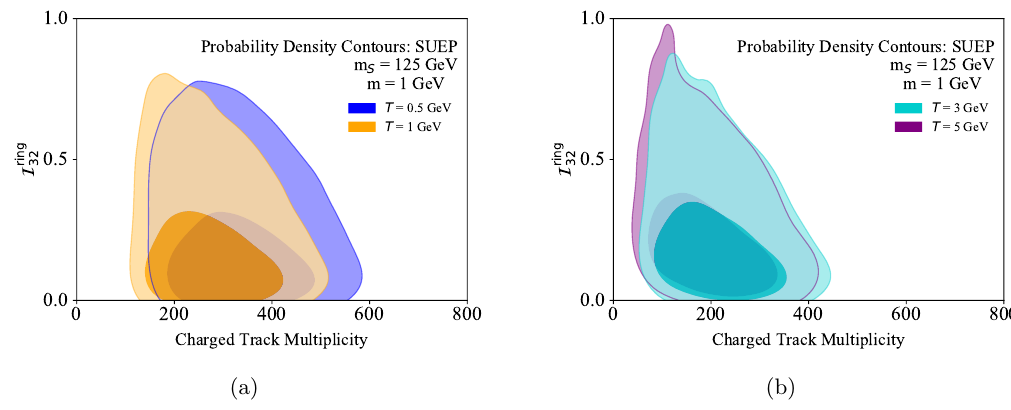
Figure 22 . Probability density contours in track multiplicity and event isotropy space for SUEP scenarios with m = 1 GeV and (a) T = f 0 : 5 ; 1 g GeV and (b) T = f 3 ; 5 g GeV. The darker regions contain 68% of the events, while the lighter regions contain 95% of the